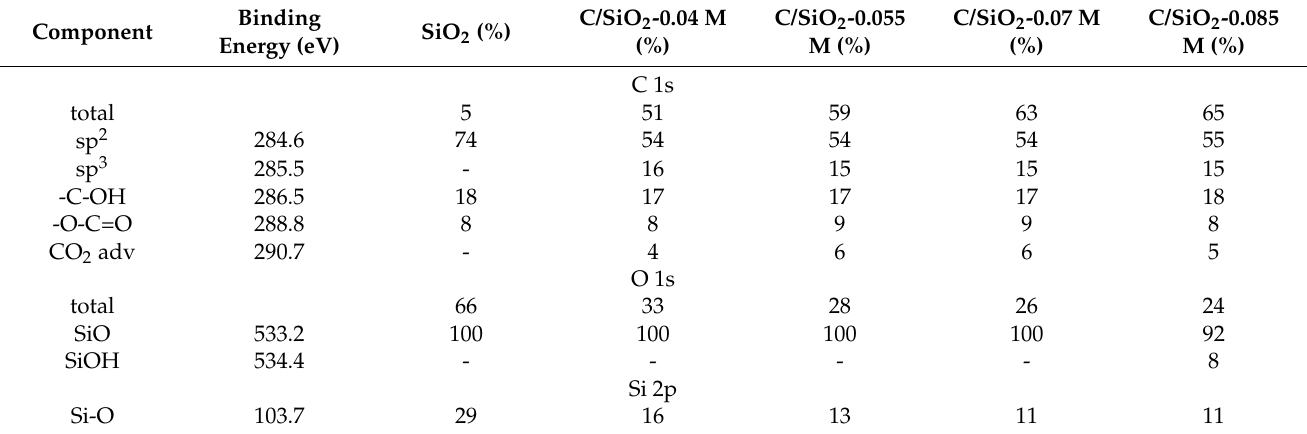
samples morphology and to confirm the XRD results (Figure 4). The high-resolution trans-